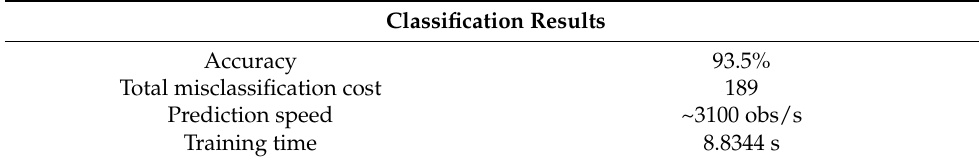
Figure 13. Classification results and confusion matrix for thin samples based on reflection mode. ( a ) Feature patterns of classification results of the cubic SVM model (Observation 485 vs. Feature 368). ( b ) Feature patterns of classification results of the cubic SVM model (Observation 1 vs. Feature 926). ( c ) Confusion matrix. Table 13. Classification results for thin samples based on reflection